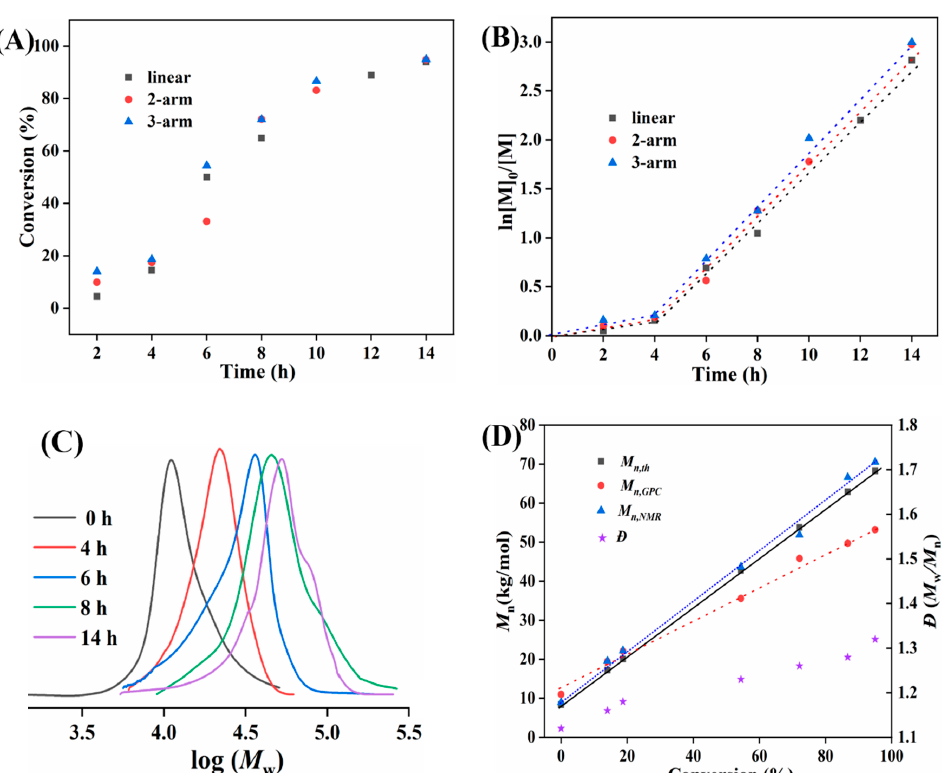
Figure 5. Polymerization kinetics ( A ) and semilogarithmic plots ( B ) of RAFT dispersion polymerization mediated by linear and 2-, and 3-armed star (PS-TTC) n . GPC traces ( C ) and evolution of M n,th , M n,NMR , M n,GPC , and Đ values ( D ) in (PS 25 -TTC) 3 -mediated PISA of 4VP. In addition, the formation process of the 3-armed star-shaped (PS 25 - b -P4VP) 3 nanoparticles was recorded by TEM as shown in Figure 6. With the increase in P4VP, (PS 25 - b -P4VP) 3 nanoparticles changed from 16.3 ± 1.4 nm nanospheres at the beginning of 4h to 53.8 ± 3.9 nm nanospheres at 8h, and finally to worms of (PS 25 - b -P4VP 190 ) 3 . However, the linear PS 24 - b -P4VP was still a solid sphere when the length of P4VP was 290 (Figure 4). Figure 6F summarizes the average diameter ( D ) of the (PS 25 - b -P4VP) 3 and linear PS 24 - b - P4VP nanoparticles with the DP of P4VP arms increasing, showing that the average diameter of (PS 25 - b -P4VP) 3 changed very little after 10 h, which may be related to the change in morphology from nanospheres to worms. Moreover, the rate of change with the DP was different for the 3-armed (PS 25 - b -P4VP) 3 and linear PS 24 - b -P4VP block copolymer nanoparticles.